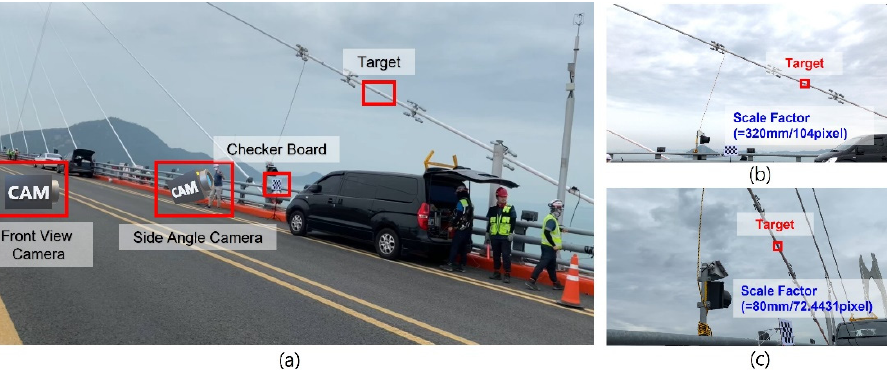
Figure 14. ( a ) Configuration of the on-site validation test with an image taken from ( b ) front view camera and ( c ) side view camera.